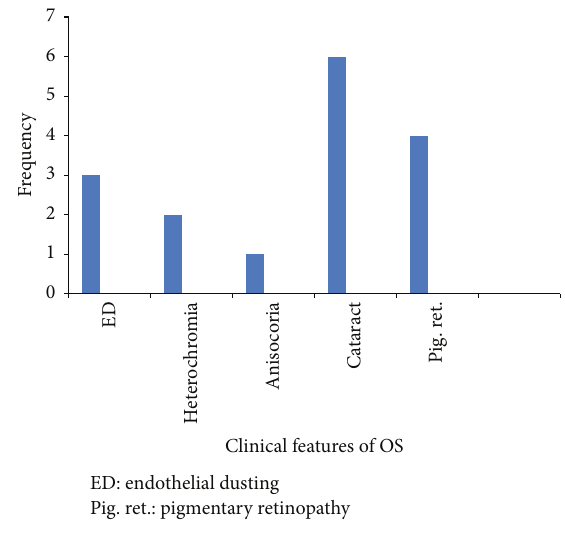
Figure 1: Clinical features of ocular